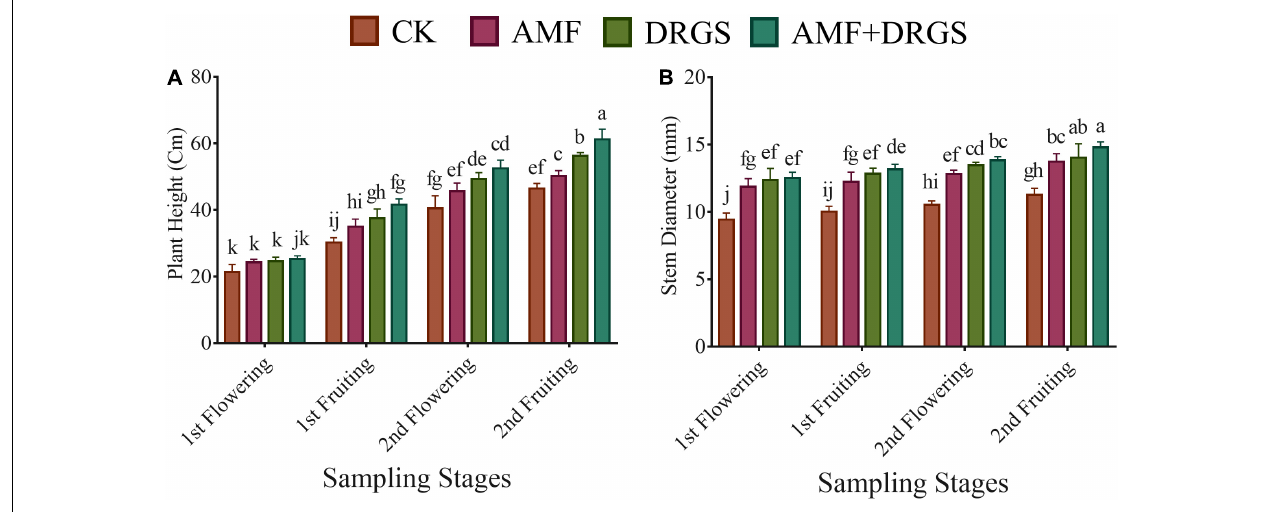
FIGURE 1 | Effect of AMF inoculation and DRGS treatment on (A) plant height and (B) the stem diameter of eggplant. Data represent the means of ± S.E. ( n = 5). Different letters show significant differences within treatments. Tukey’s HSD test was employed to verify statistical significance at p < 0.05.